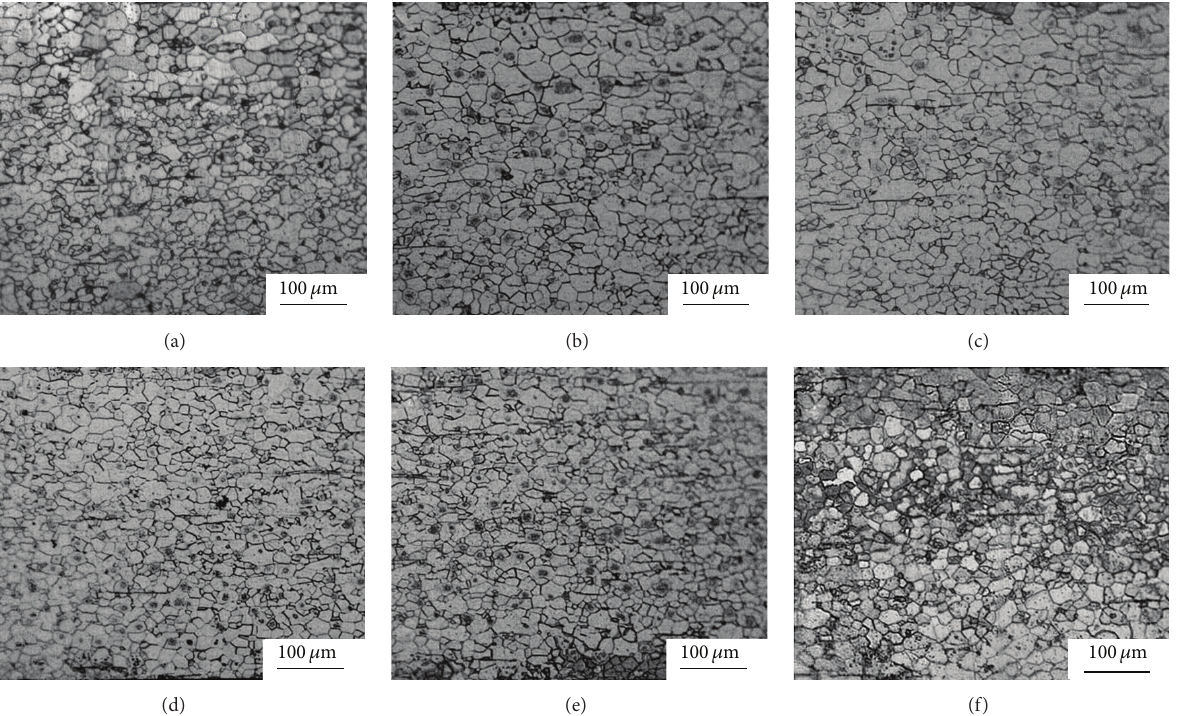
Figure 1: Microstructures of tested samples under different intermediate temperatures during primary recrystallization: (a) 800 ∘ C + 850 ∘ C; (b) 840 ∘ C + 850 ∘ C; (c) 860 ∘ C + 850 ∘ C; (d) 800 ∘ C + 820 ∘ C; (e) 840 ∘ C + 820 ∘ C; (f) 860 ∘ C + 820 ∘ C.